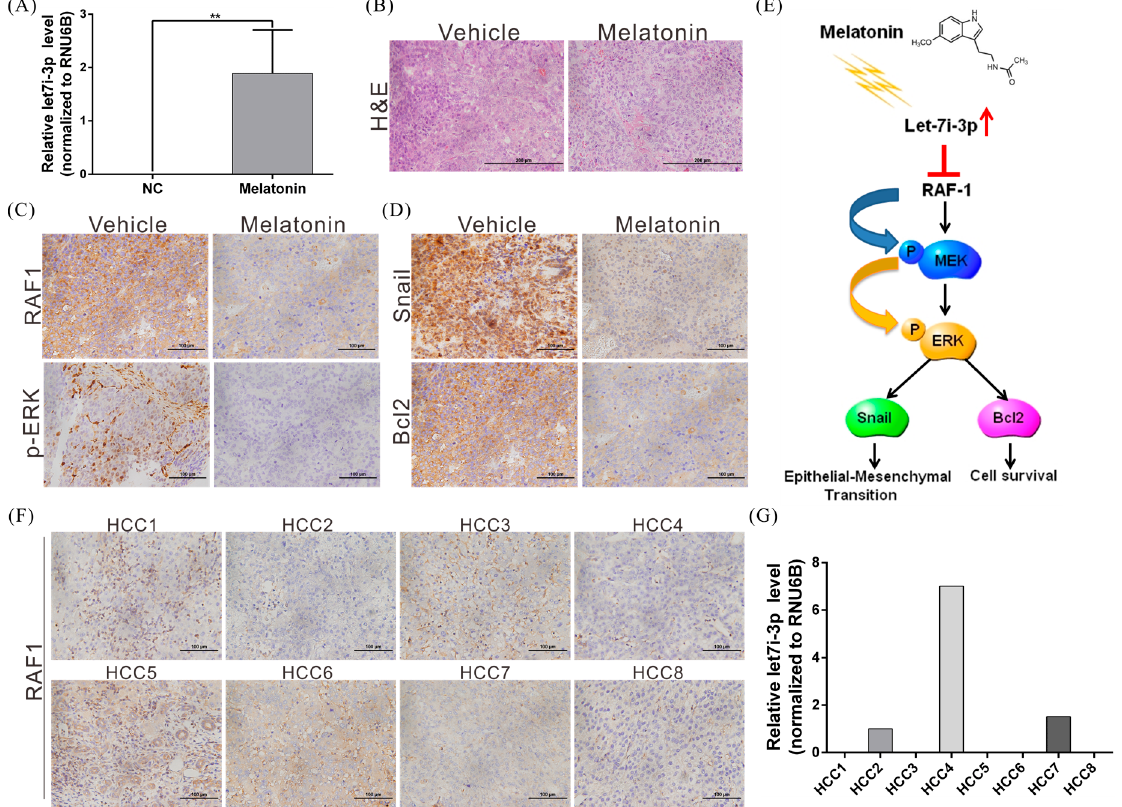
Figure 7. Melatonin induces let7i-3p expression and thereby suppresses RAF1 and its downstream oncogenic pathway. ( A ) Xenograft tumors were excised from mice at the end of experiments and subject to real-time PCR for detecting let7i-3p expression; ** p < 0.01. ( B ) Hematoxylin and eosin (H&E) staining was performed to analyze tissue morphology. ( C , D ) Immunohistochemical staining showing the effect of melatonin on RAF1, phospho-ERK (P-ERK), Snail and Bcl2 protein expression in mouse xenograft tumors. Magnification: 400×. ( E ) A schematic summarizing the mechanism by which melatonin suppresses HCC progression. ( F , G ) Inverse relationship between let7i-3p and RAF1 expression in tissues from patients with HCC. Scale bar = 100 μ m.